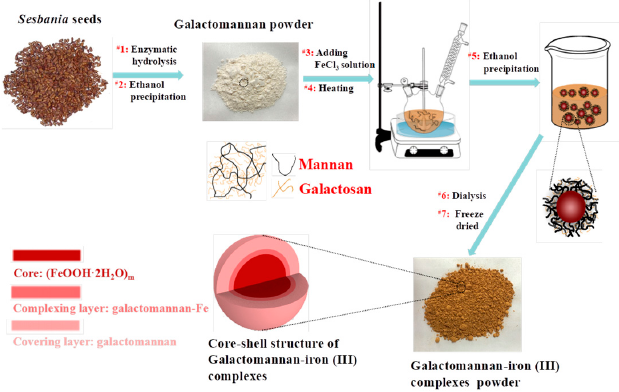
Figure 1. Flow chart of the synthesis the galactomannan – iron(III) complexes from Sesbania seed.